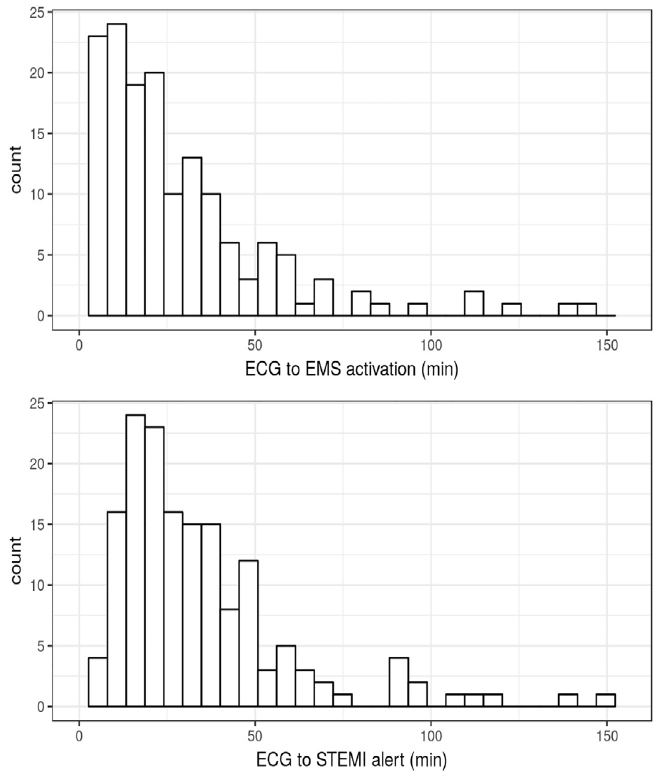
Figure 2. Histogram of electrocardiogram (ECG)-to-emergency medical services activation and ECG-to-percutaneous coronary intervention activation intervals. ECGs used were those diagnostic of ST-elevation myocardial infarction (STEMI). min,